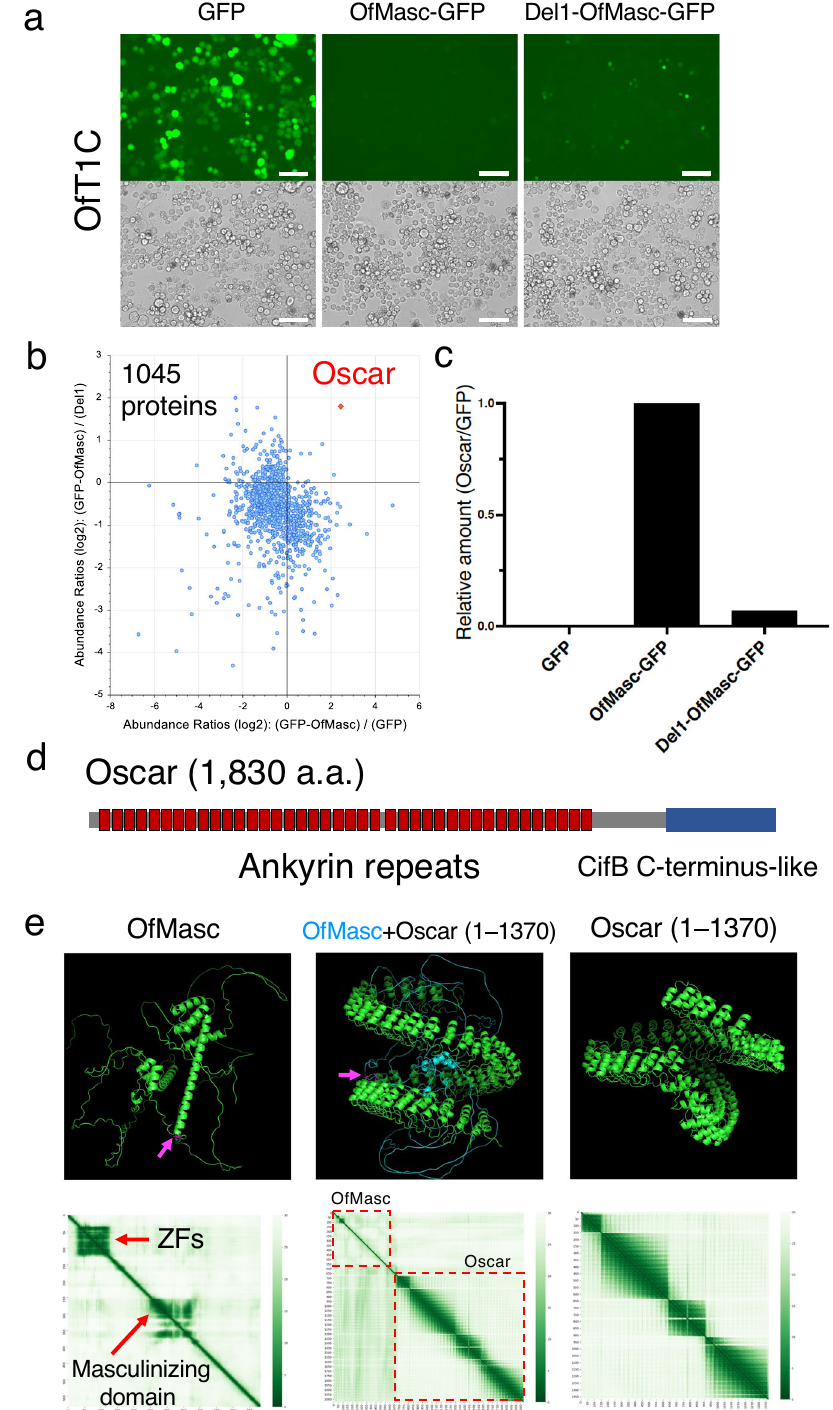
Fig.2|Identi fi cationofOscarastheOfMasc-interactingprotein.a Fluorescence microscopy of OfT1C cells transfected with GFP , OfMasc-GFP , or Del1-OfMasc-GFP cDNAs. Bar, 100 µ m. Similar results were obtained in three independent experi- ments. b LC-MS/MS analysis of immunoprecipitates with anti-GFP nanobody from GFP -, OfMasc-GFP- , or Del1-OfMasc-GFP- transfected OfT1C cells. Dots indicate host and w Fur proteins identi fi ed by label-free precursor ion quanti fi cation (1045 pro- teins). Oscar is indicated by the red dot. Similar results were obtained in two independent experiments. c Parallel reaction monitoring (PRM) quanti fi cation of relative amount of Oscar to GFP in GFP -, OfMasc-GFP- , or Del1-OfMasc-GFP-